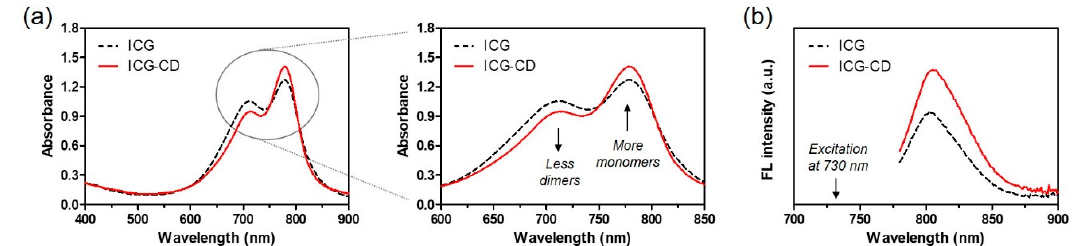
Figure 2. Optical properties of free ICG and the ICG-CD complex. ( a ) Changes in absorbance spectra of the ICG and ICG-CD solutions at the same ICG concentration. Amplification of the 710 nm and 780 nm regions showing changes in absorbance of ICG-dimeric and ICG-monomeric forms in PBS. ( b ) Fluorescence spectra of ICG and ICG-CD solutions upon excitation at 730 nm. Absorbance and fluorescence emission spectra of each sample were obtained at a fixed ICG concentration of 10 µM in PBS at pH 7.4.